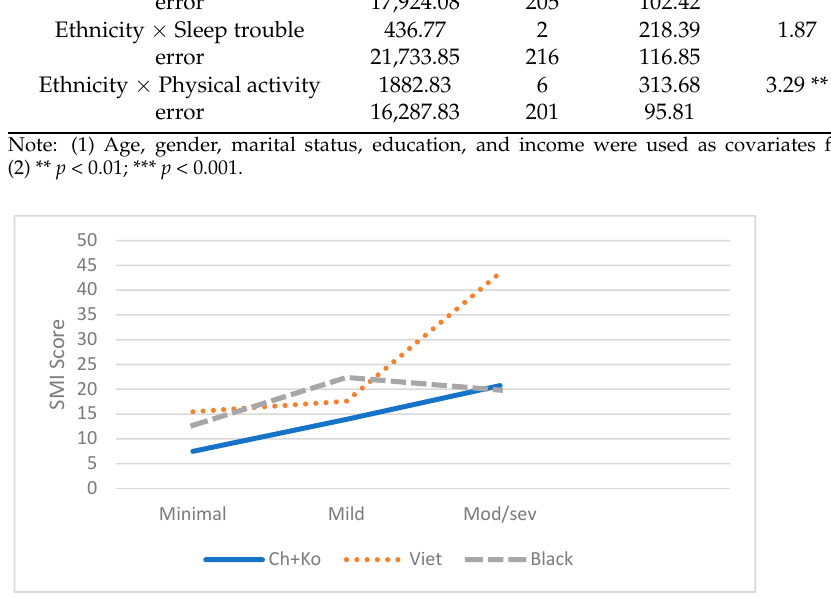
Figure 2. Effect of Depressive Symptoms on SMI by Groups.